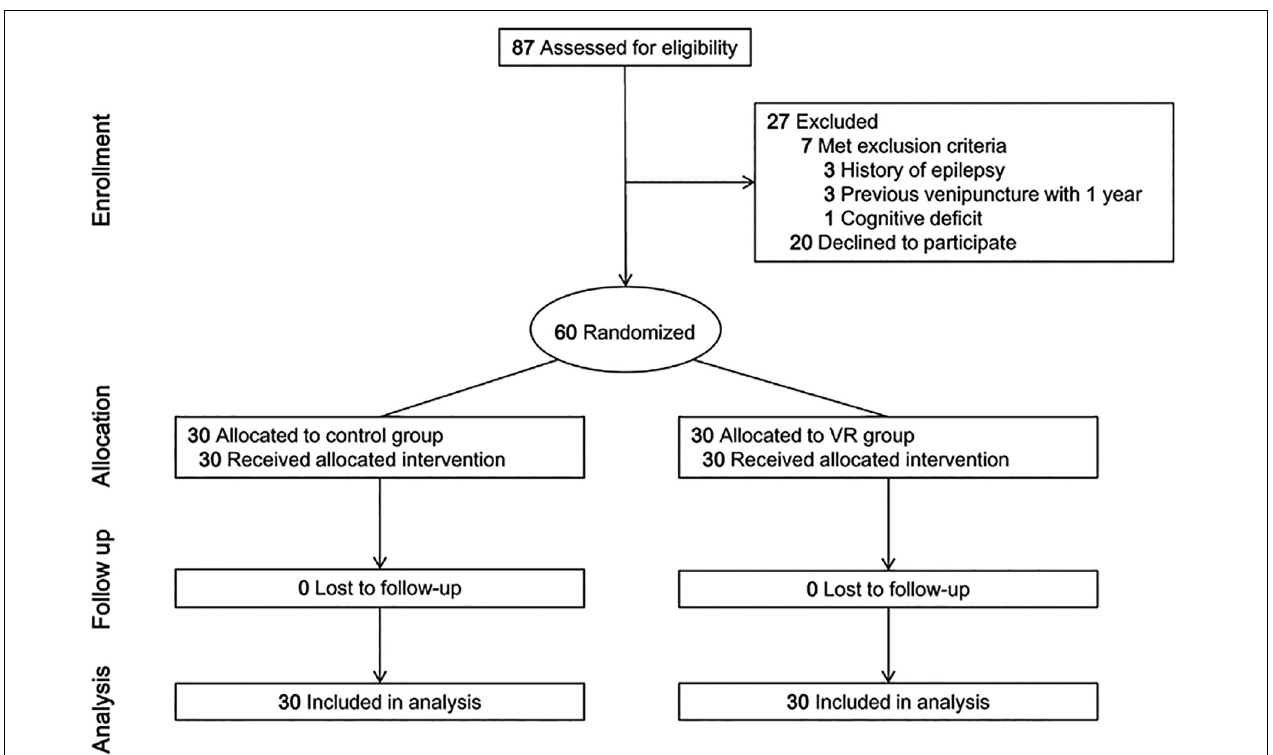
FIGURE 2 | CONSORT flow diagram. VR, virtual reality.